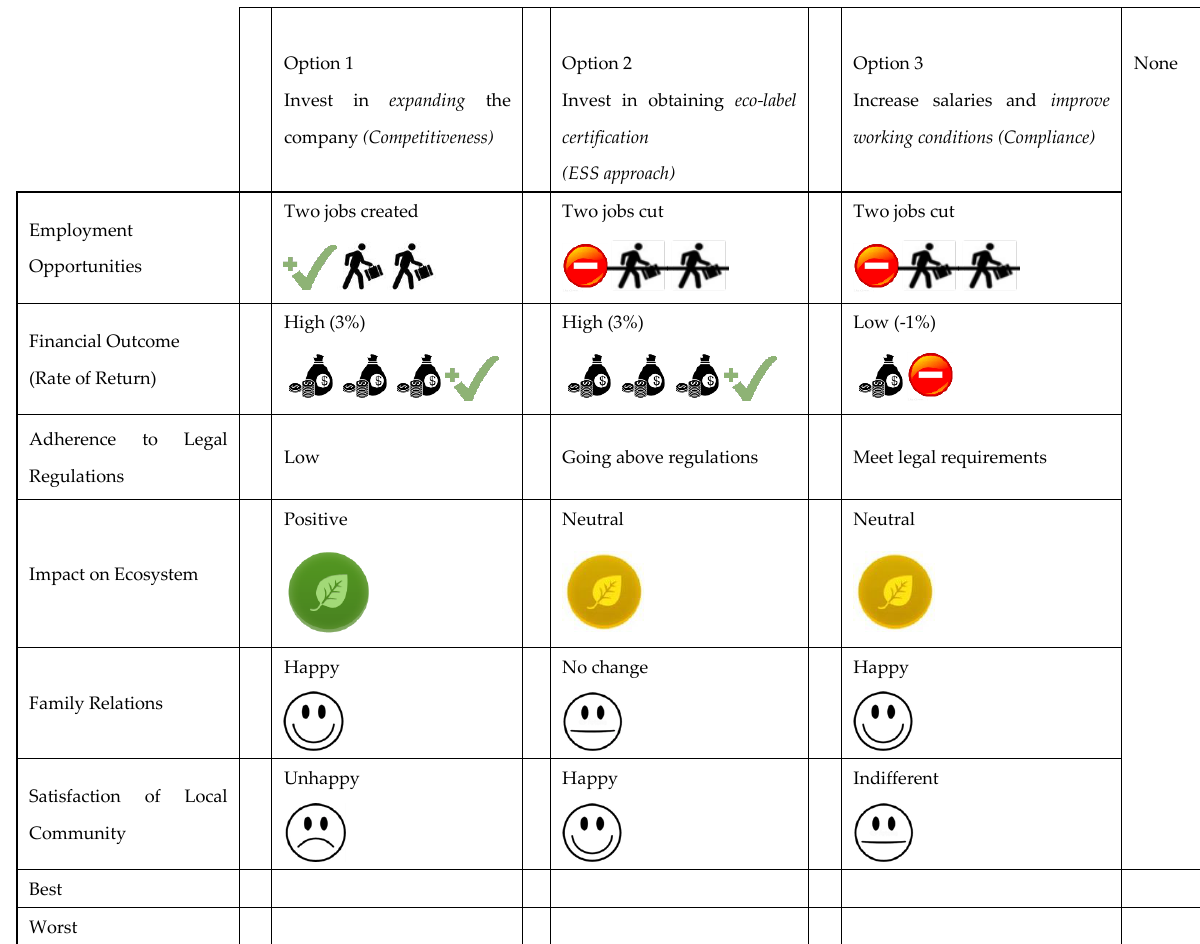
Figure 1. Example Experiment from the Survey Instrument (1 out of 6 shown to each